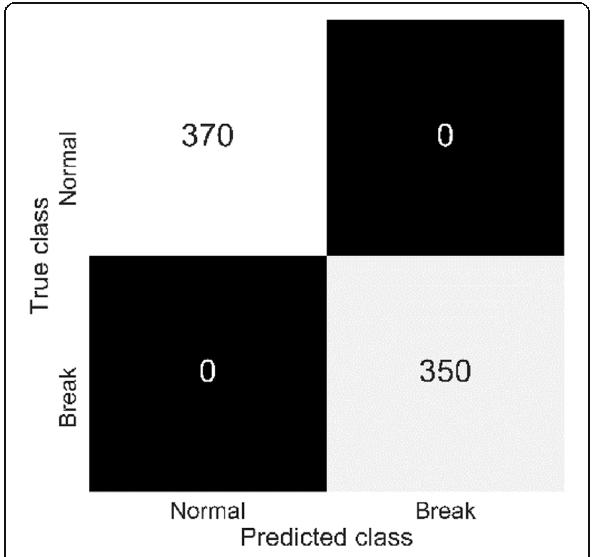
Fig. 8 The confusion matrix of the classification result of leaking and non-leaking cases by the trained ANN model (achieved 100% accurate with no misclassification)